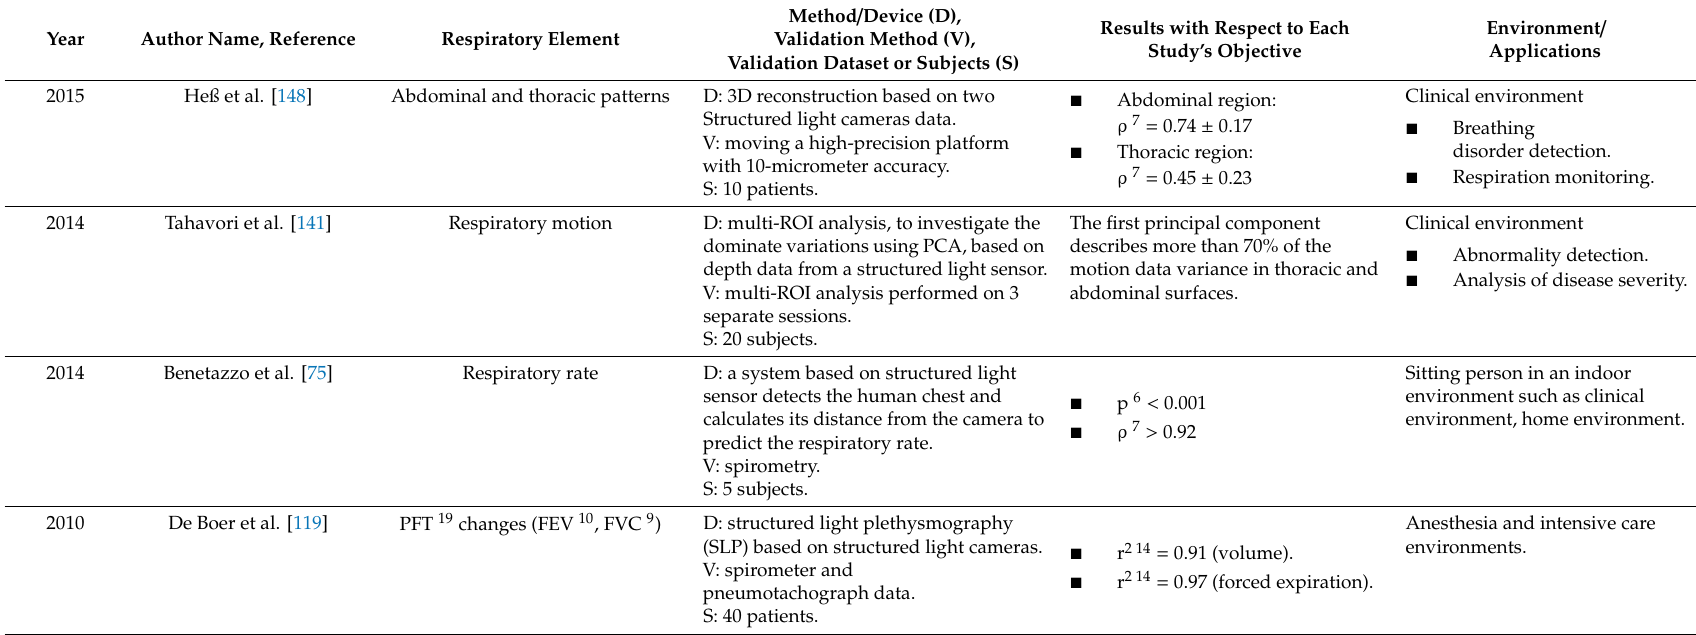
D: 3D reconstruction based on two Structured light cameras